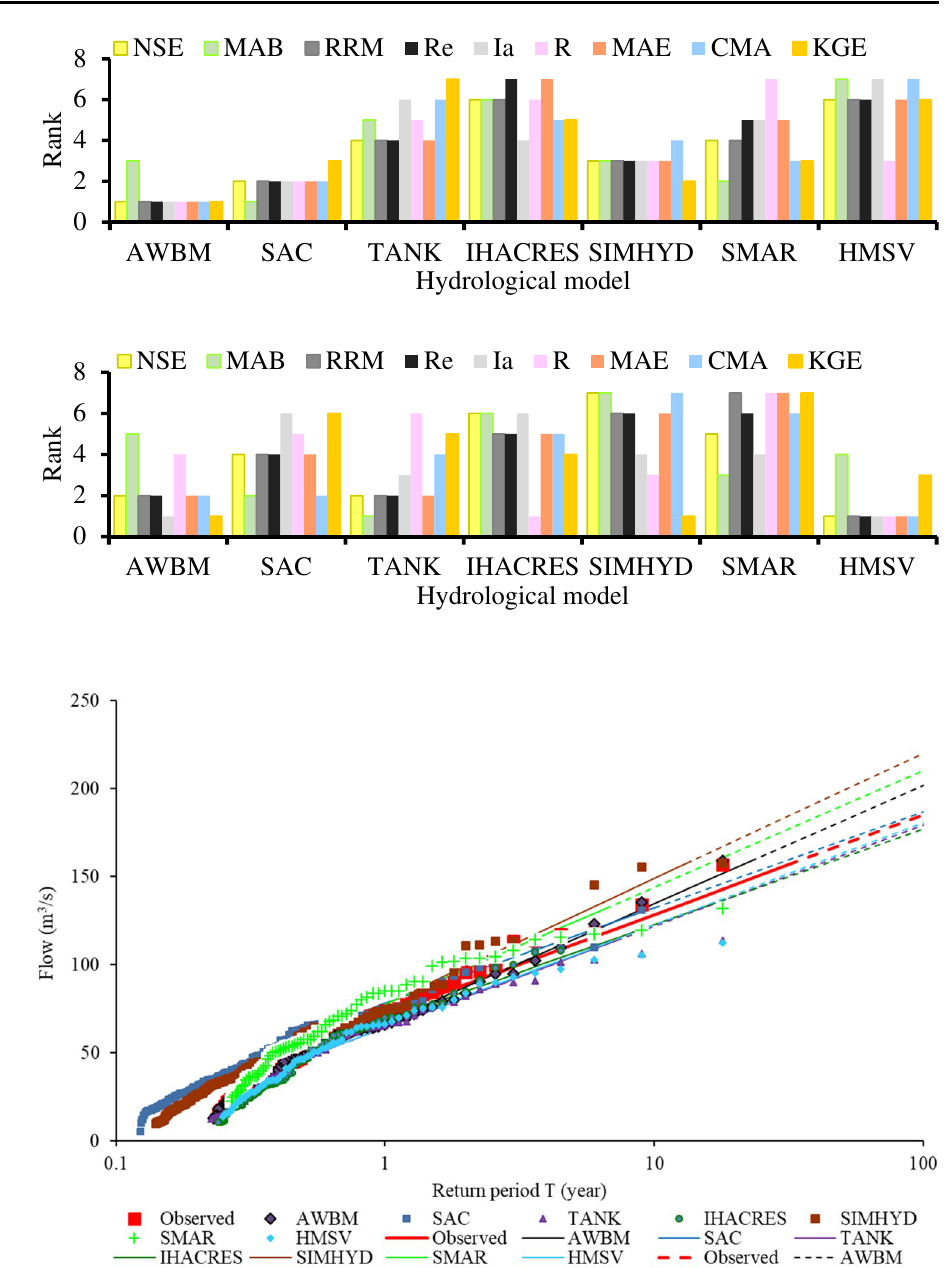
Fig. 8 Assessment of model performance based on com- piled values of ranking from all the nine “goodness-of-fit” con- sidering the annual maxima flows. The best performing model is ranked 1 while the worst takes rank 7